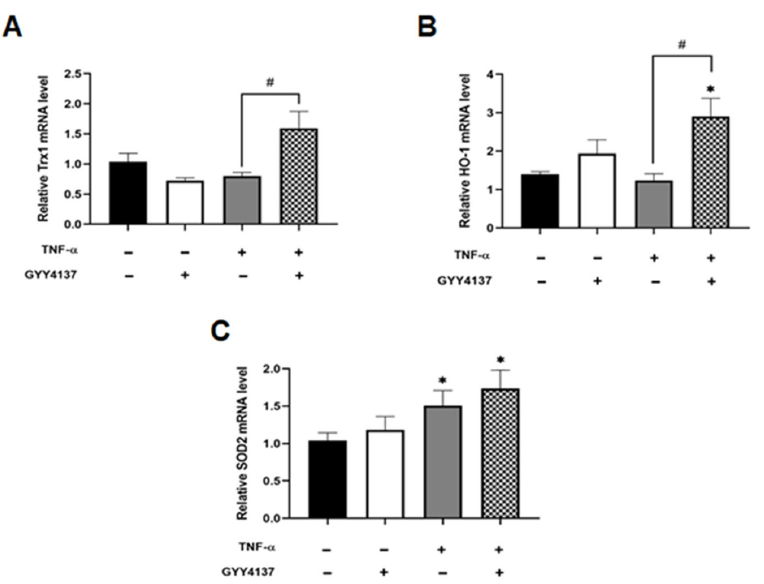
Figure 5. GYY4137 post-treatment increase intracellular antioxidants in TNF- α -treated cells. The extracted RNA was reverse transcribed to cDNA and calculated using the ΔΔ Ct value method with two duplicates and with EEF2 as a housekeeping gene. Bar graphs of relative ( A ) Trx1, ( B ) HO-1, and ( C ) SOD2, mRNA expression was analysed by RT-QPCR. Results were shown as mean ± SD (N = 4 independent experiments with 3 replicates in each experiment. One way ANOVA test was carried out, followed by Tukey’s post hoc test to normalise for multiple comparisons comparing treatment vs. control, whereby (* p < 0.05) compared to control. (# p < 0.05) represents a comparison to the TNF- α group alone.